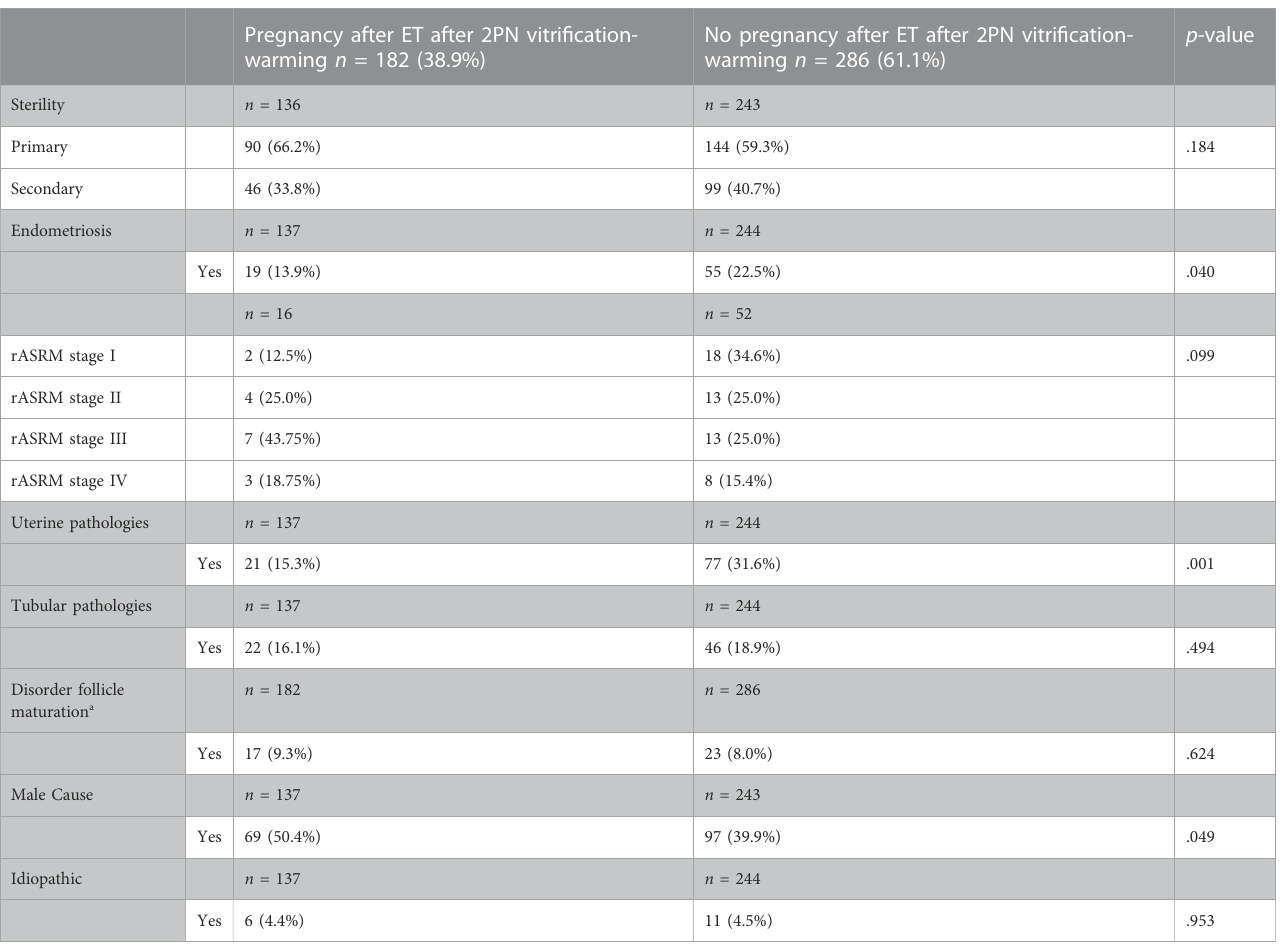
TABLE 2 Overview of indications for fertility